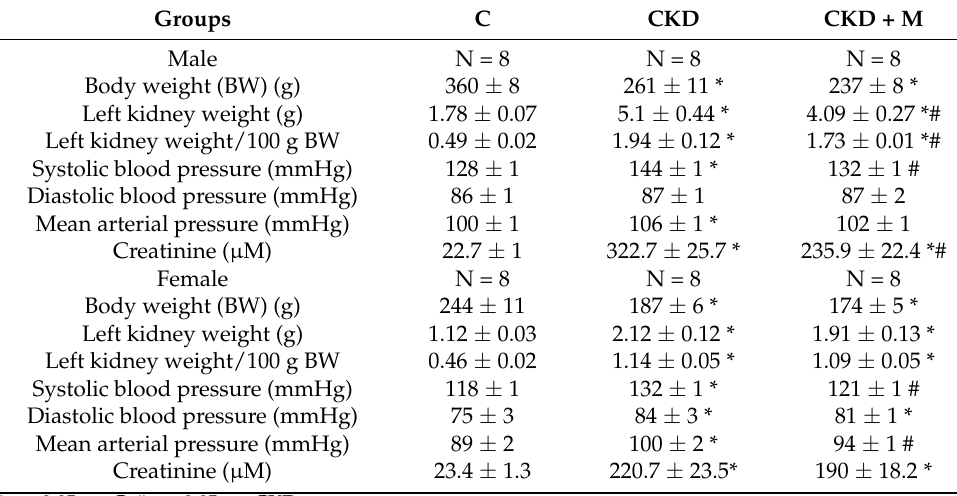
Table 1. Weights, blood pressure, and renal function.